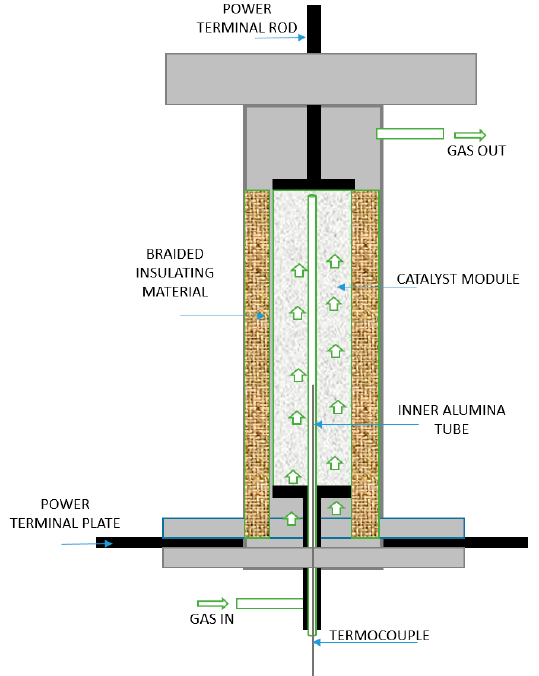
Figure 5. Schematic diagram of catalytic electrified reactor. Adapted from [12].